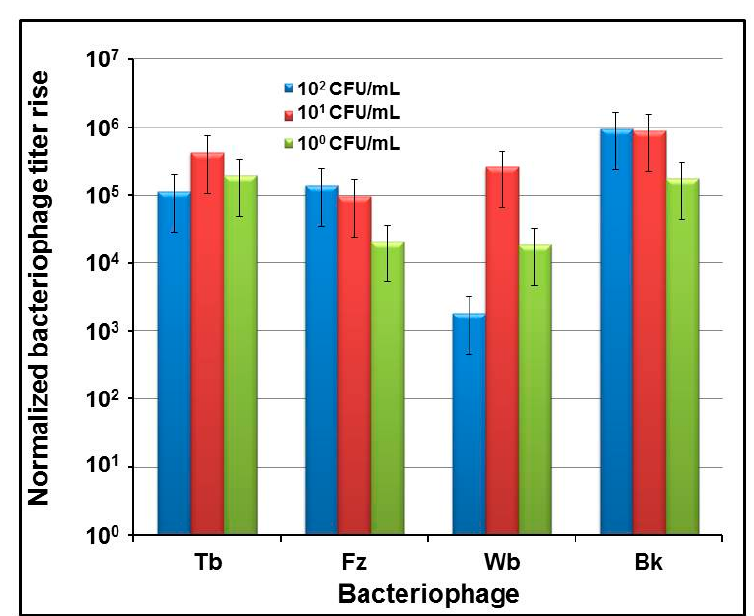
Figure 3. Amplification of brucellaphages Tb, Fz, Wb, and Bk on low concentrations of B . abortus S19. Phage lysates were diluted in saline magnesium (SM) buffer and added at 10 3 PFU/mL to the dilutions of bacterial culture in Brucella Broth at concentrations of ~1 × 10 2 ; ~1 × 10 1 and ~1 × 10 0 CFU/mL, which were confirmed by live bacterial counts. qPCR was performed after 72 h of incubation of each test culture with the corresponding phage.